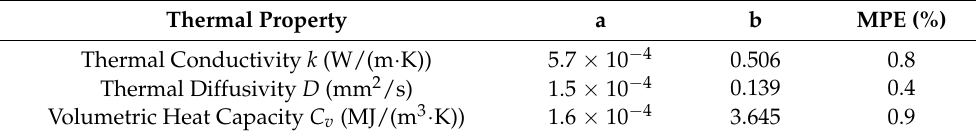
Table 6. Regression coefficients and mean percentage error (MPE) of the model for pancreas